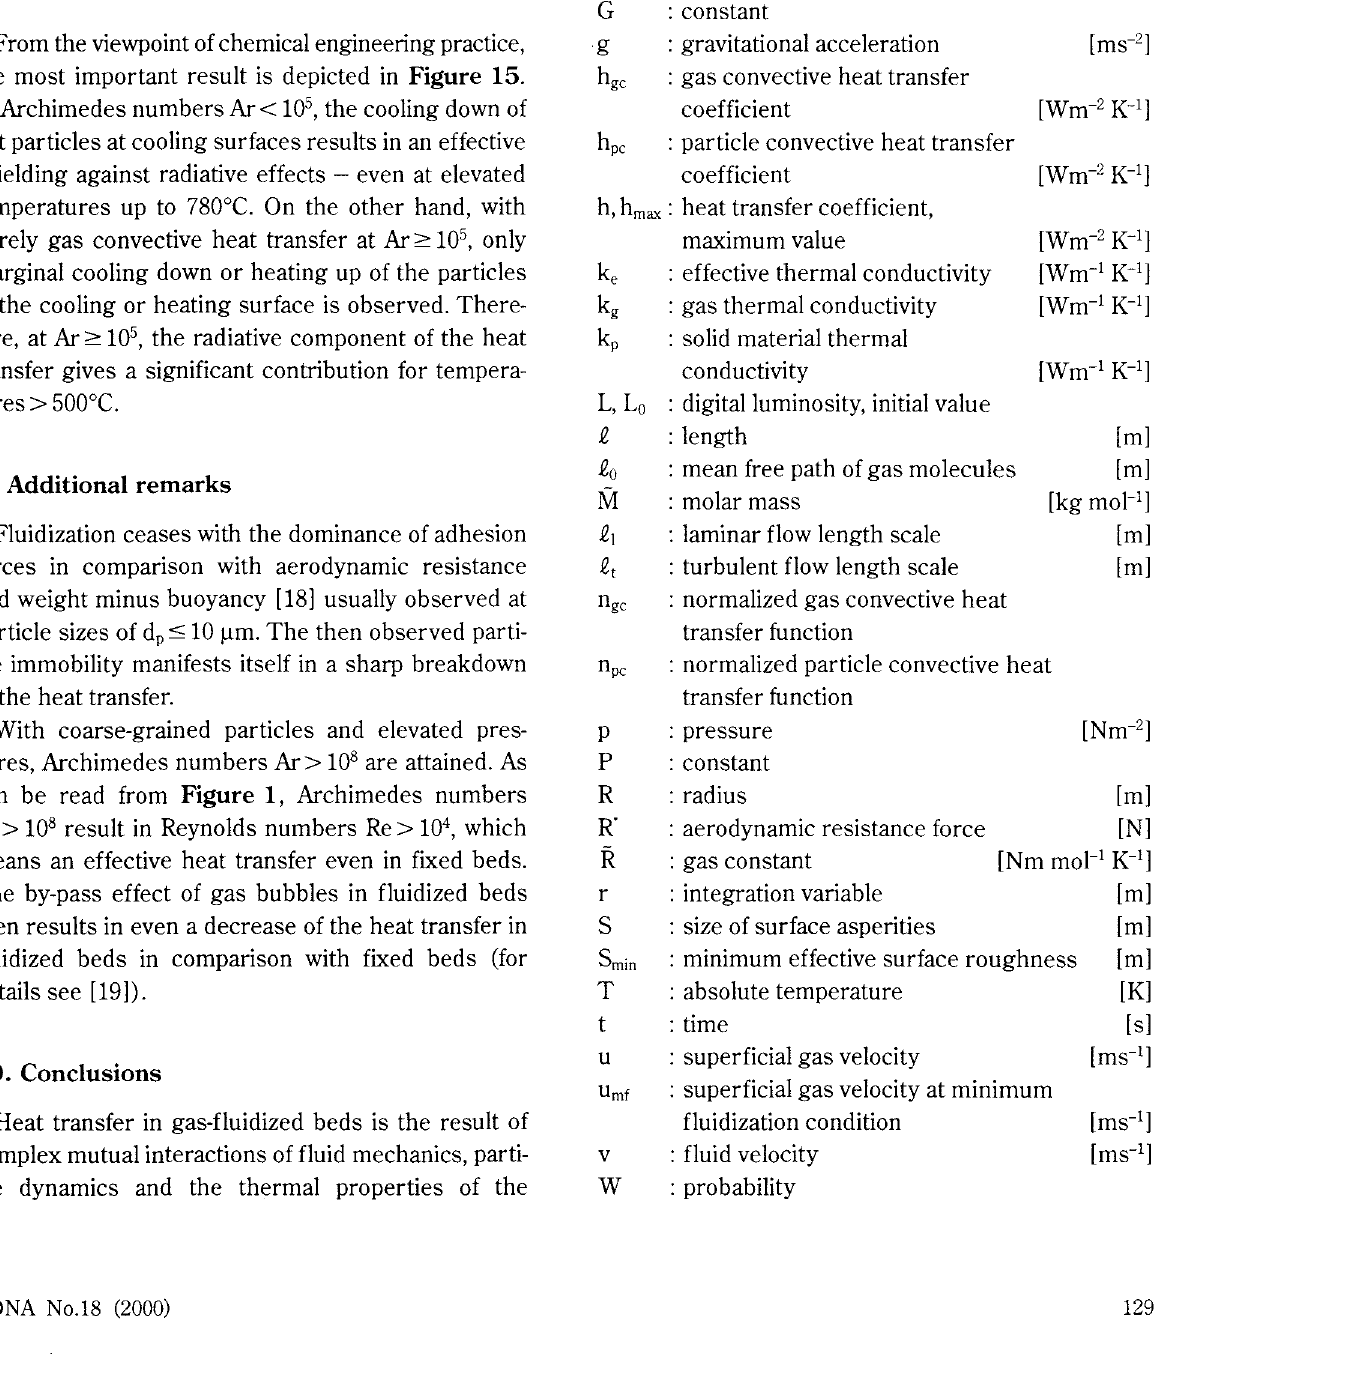
Fig. 15 Measurements (symbols) with sand-air, bed tempera ture varied, heat transfer surface: horizontal tube, data from Janssen [17], prediction (lines) according to Eq.